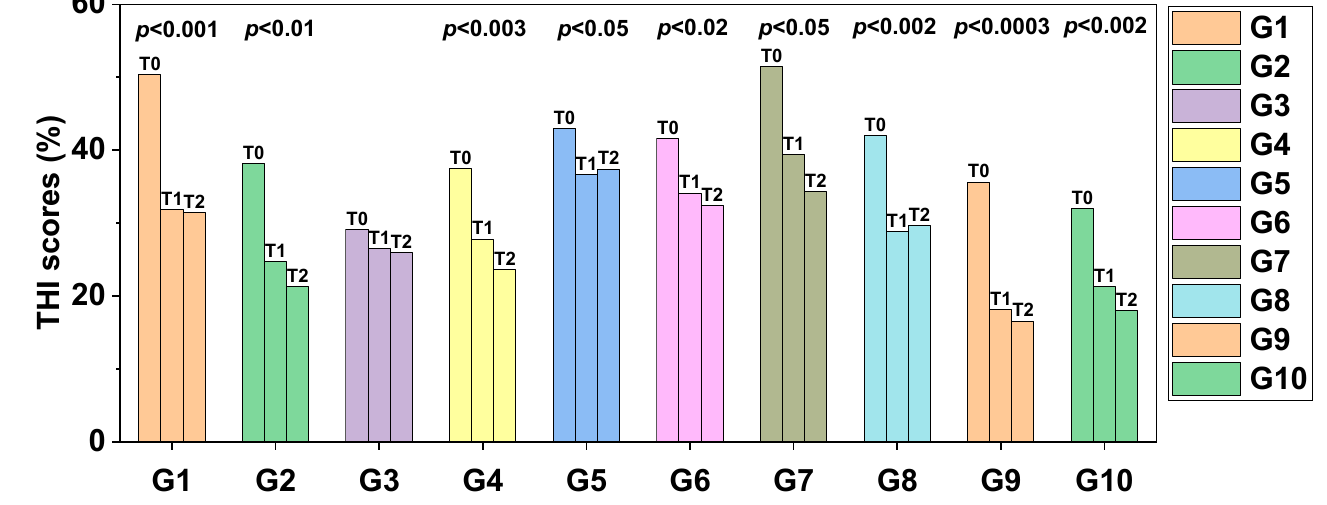
Figure 5. Barplot comparing the non-normalized THI scores at T 0, T 1 and T 2 between tinnitus treatment modalities explored in this study (from G1 to G10). The left bar of each group represents initial THI scores before any treatment (period T 0). The middle bar of each group represents scores after 8 treatment sessions (period T 1). The right bar of each group represents the final THI scores 15 days after completely suspending treatment of any sort (period T 2). Statistically significant differences between T 2 and T 0 were observed for all groups except for G3. The ballpark of p -values obtained can be seen in the top of the bars of each group.